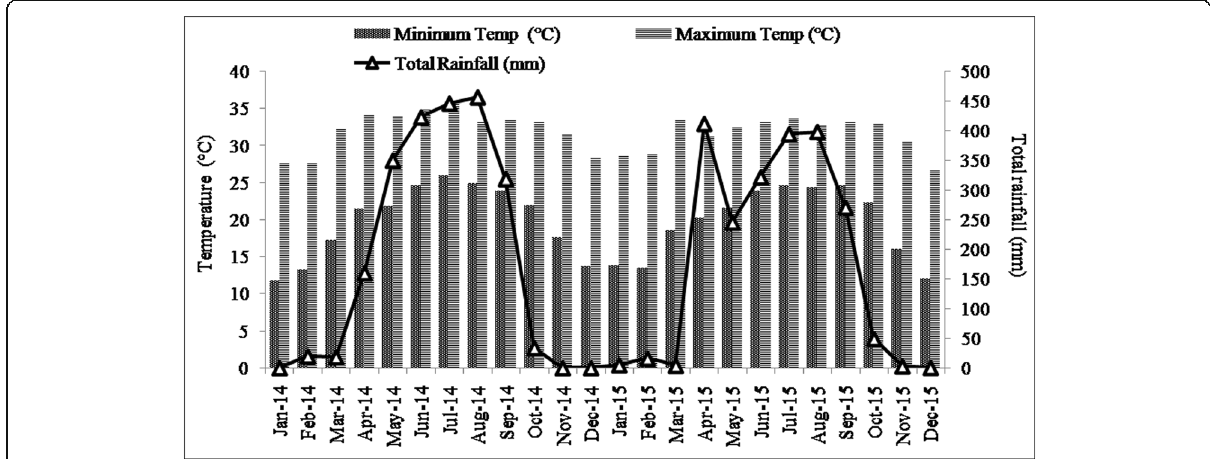
Fig. 2 Monthly variations in total rainfall and atmospheric temperature in Cachar district during study period (2014 – 2015). The study was carried out during early-flood phase (EFP; May to June), mid-flood phase (MFP; July to August) and late flood phase (LFP; September to